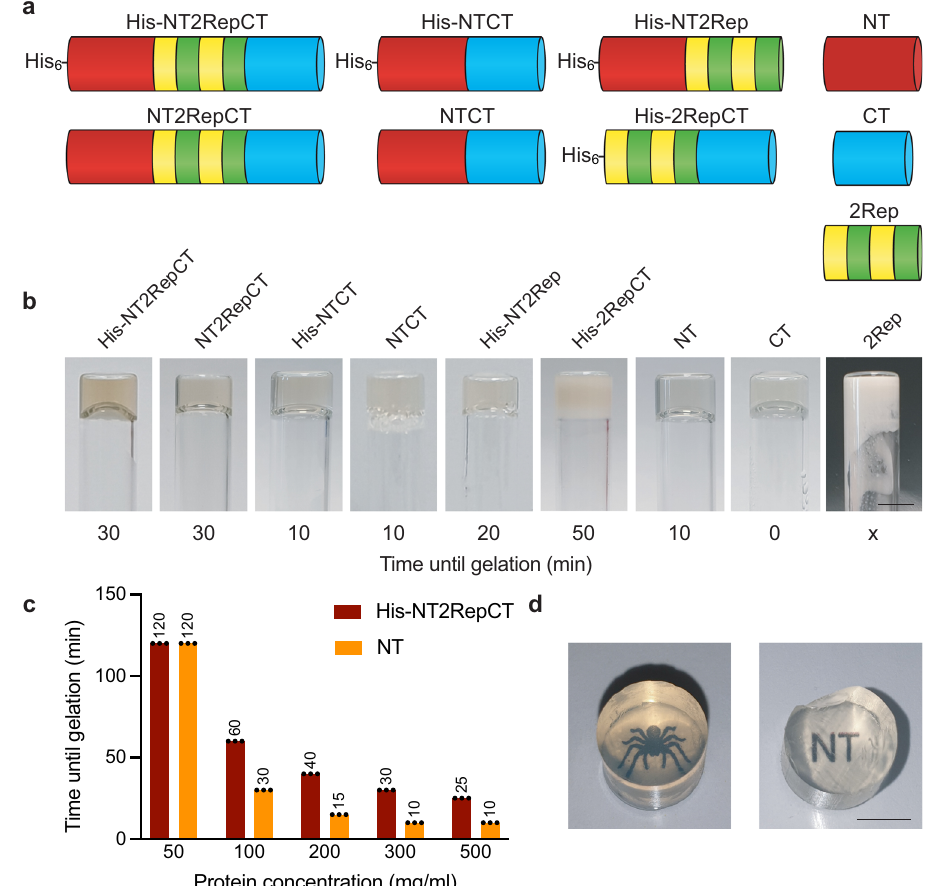
Fig. 1 | Temperature-induced hydrogel formation of His-NT2RepCT and its different domains. a Schematic presentation of the different spidroin constructs investigated herein. b Gelation times of the different recombinant spidroins (300mg/ml) at 37°C as tested by vial inversion. CT gelled immediately without incubation (<300mg/ml) and 2Rep precipitated (300mg/ml, scale bar is 5 mm).